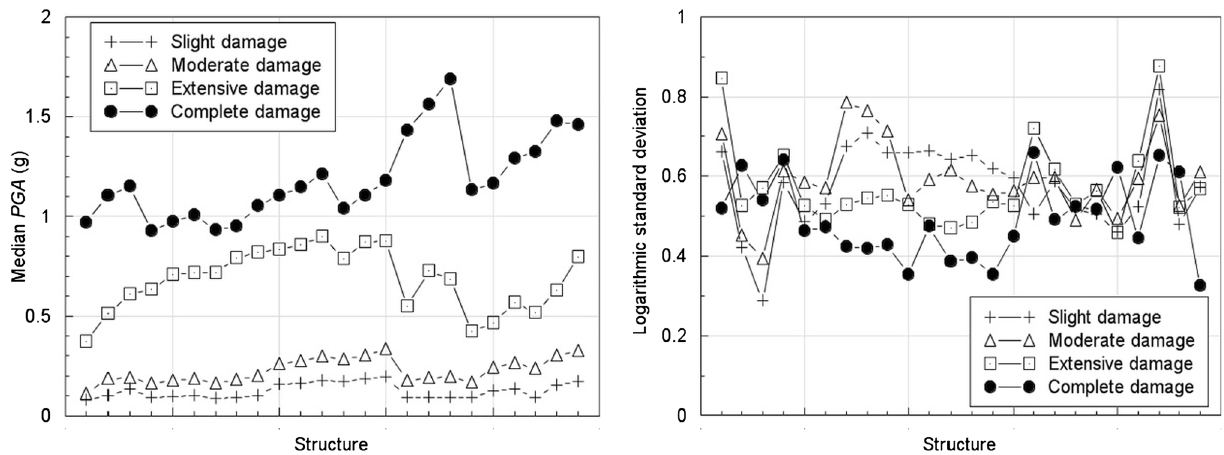
Fig. 6 Median peak ground acceleration ( PGA ) (left plot) and logarithmic standard deviations (right plot) for the fragility curves obtained using FRACAS for structures in Bucharest, Romania